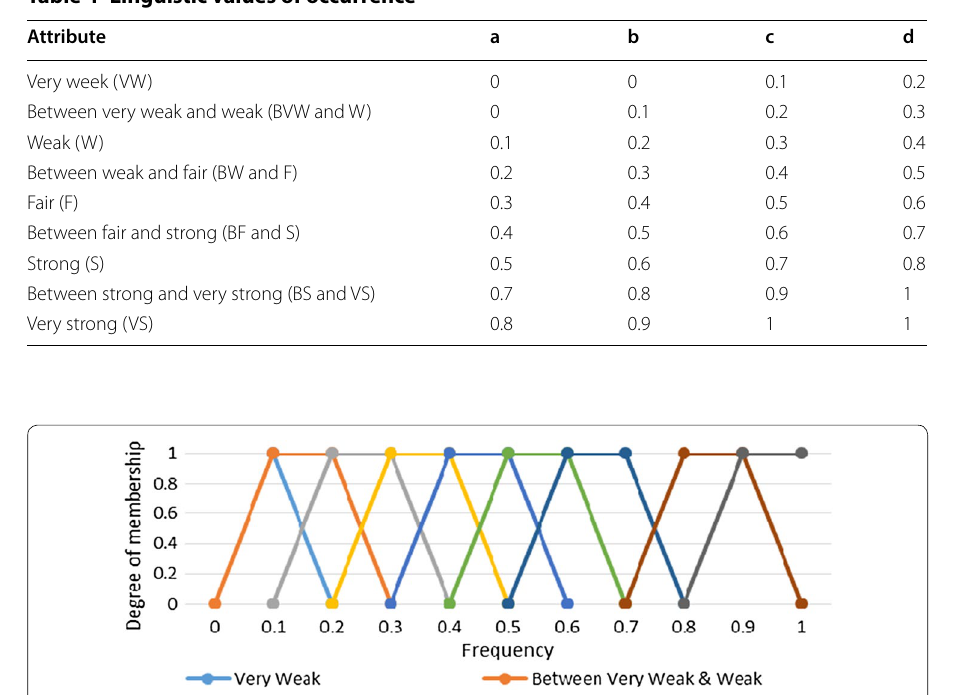
Table 4 Linguistic values of occurrence